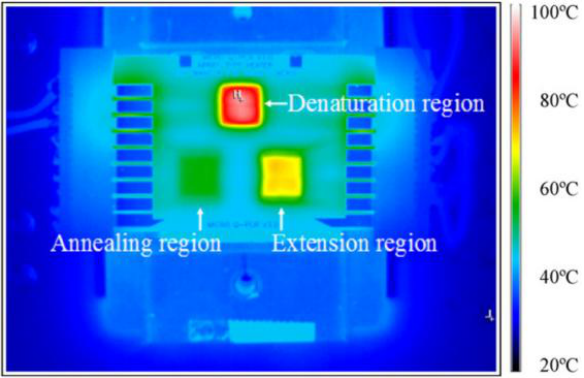
Figure 13. IR images of the device showing the three different temperature zones (5, 72 and 94 °C). Reprinted from [15], Copyright 2004, with permission from